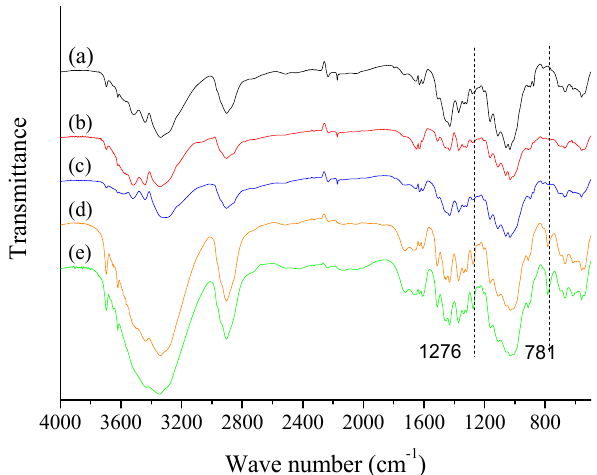
Figure 3. FTIR spectra of ONP fibers treated with different MTCS dosages: (a) 0 ( v / w ); (b) 2% ( v / w ); (c) 4% ( v / w ); (d) 6% ( v / w ); and (e) 8% ( v / w ).